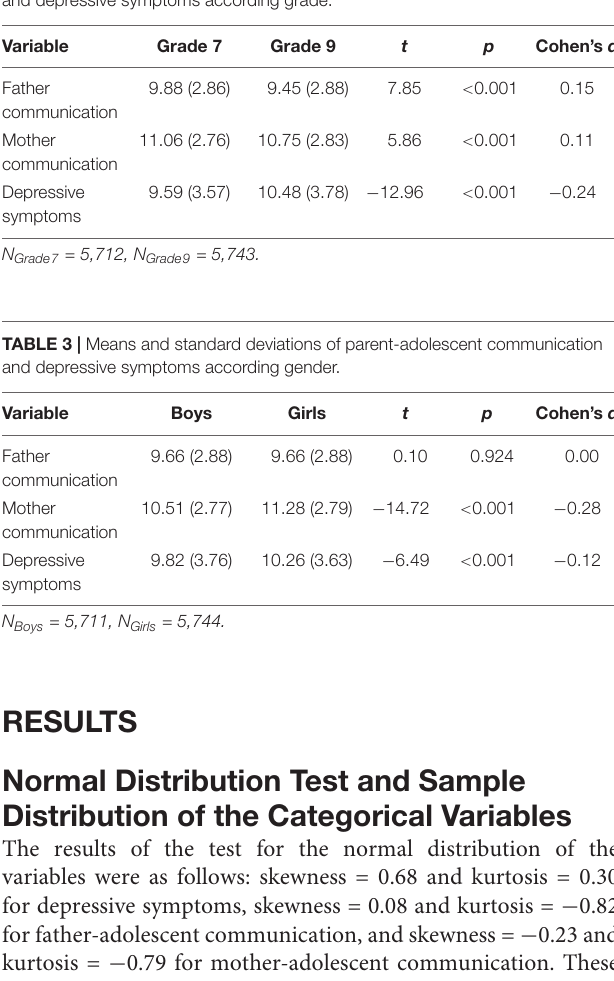
TABLE 2 | Means and standard deviations of parent-adolescent communication and depressive symptoms according grade.